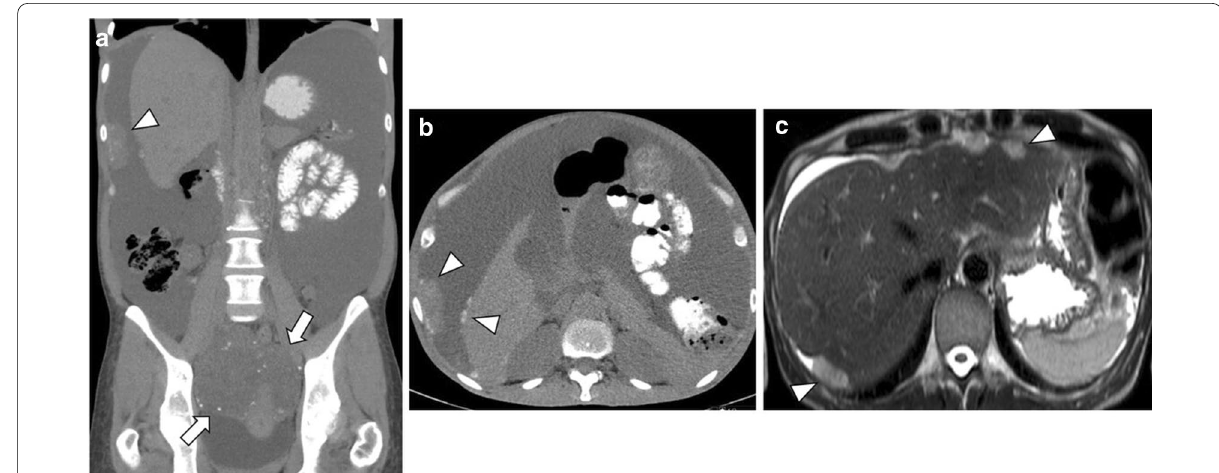
Fig. 6 Bilateral LGSC with foci of SBT with peritoneal metastases in a 48-year-old female. Coronal and axial unenhanced CT images ( a , b ) display a pelvic bilateral cystic tumour (arrows) with several calcified psammoma bodies and calcified peritoneal metastases, namely in the hepatic surface and in the right hypochondrium peritoneum (arrowheads). Severe ascites is also seen, which is a rare manifestation in this type of tumour. Axial T2-weighted MR image ( c ) demonstrates metastases adherent to the liver surface (arrowheads)